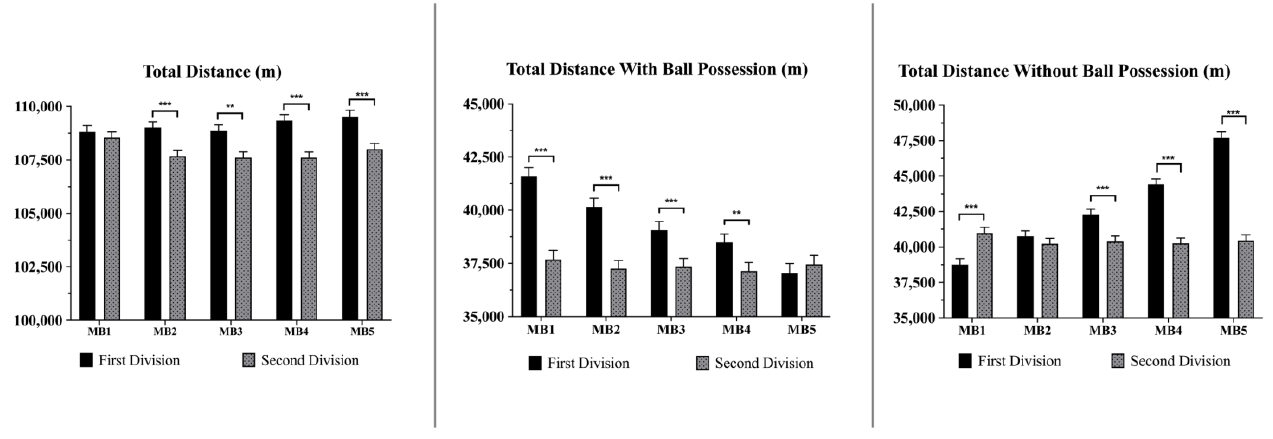
Figure 1. The total distance (in meters) with and without ball possession. ** p < 0.01. *** p < 0.001.